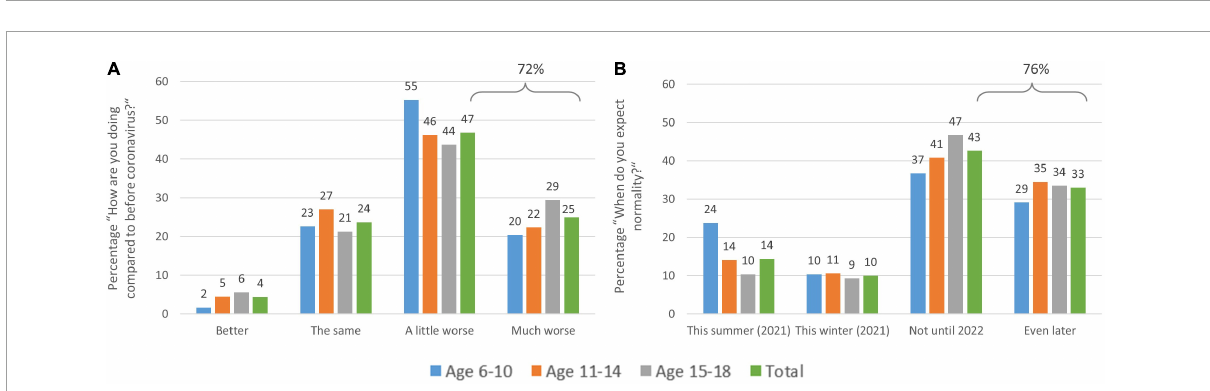
FIGURE4 Distribution of children’s and adolescents’ responses to the question: (A) “How are you doing compared to before coronavirus?” and (B) “When do you think life will be relatively ‘normal’ again?” by age group. (A) About 72% of the sample are doing worse and (B) expect normalization of the situation only in the far future (surveyed in February–April